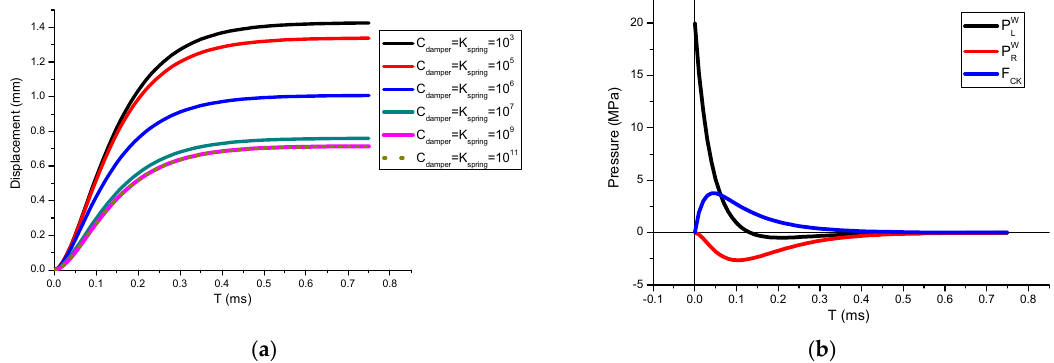
Figure 2. Time histories of ( a ) the displacement of the left plate for different values of C damp and k, and ( b ) the pressure P Lw on the left plate, P Rw on the right plate, and the internal force / area, F CK . Time histories of the resultant pressure on the left and the right plates, and the interaction pressure between them, are exhibited in Figure 2b. At t = 0.13 ms , the resultant pressure on the left plate